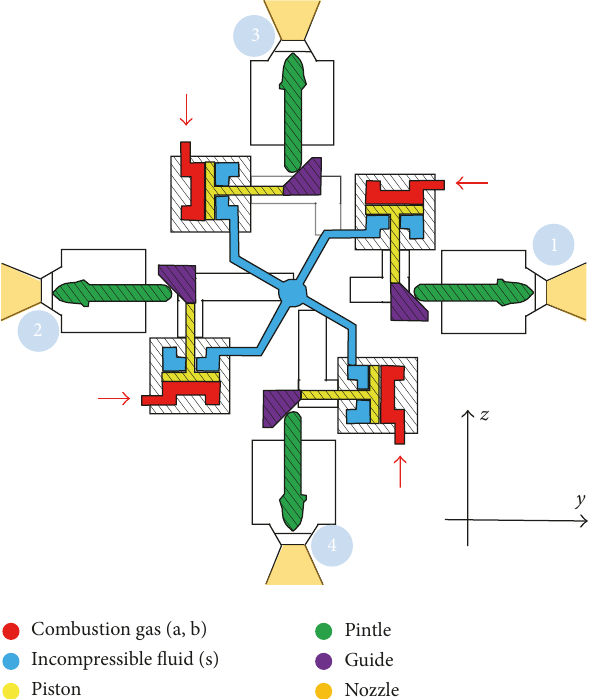
Figure 10: Schematic of the proposed pintle actuator.